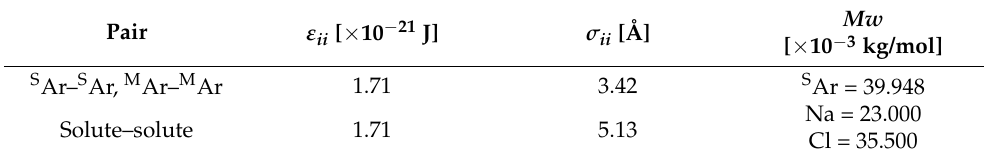
Table 1. Lennard–Jones potential parameters used in the present